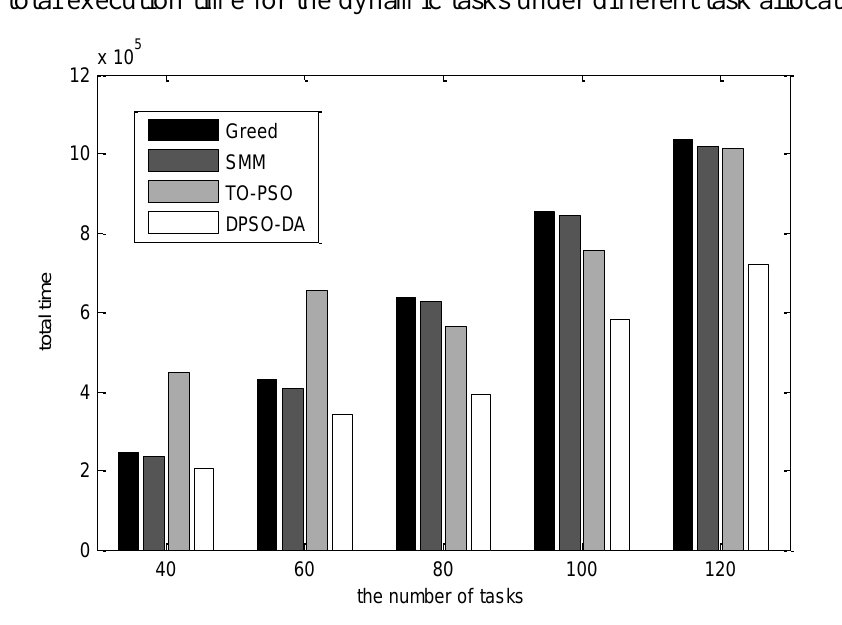
Figure 9. The total execution time for the dynamic tasks under different task allocation